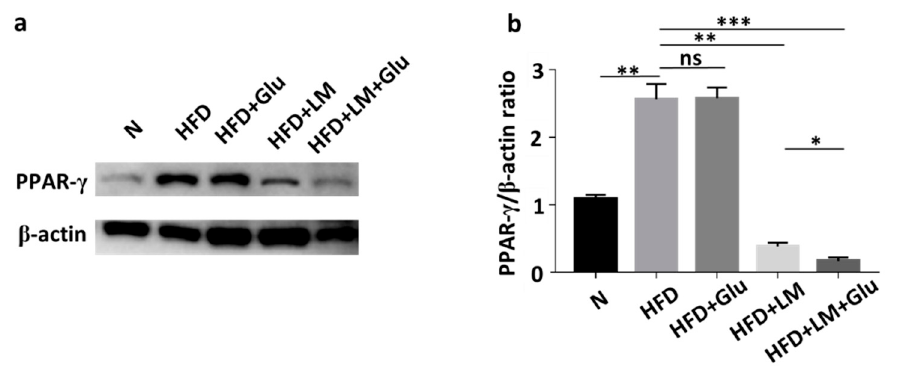
Figure 3. Attenuation of HFD-induced upregulation of PPAR- γ by L. mesenteroides EH-1. ( a ) The levels of PPAR- γ and β -actin in abdominal fat depots of mice fed with normal diet (N) or HFD along with glucose (Glu), L. mesenteroides EH-1 (LM) or L. mesenteroides EH-1 plus glucose every 3 days for 25 days were detected by western blot analysis. ( b ) The ratio intensities of PPAR- γ to β -actin were quantified. PPAR- γ expression (0.172 ± 0.050, n = 3) was reduced in HFD-fed mice with treatment of L. mesenteroides EH-1 and glucose (LM + Glu) compared to that (2.565 ± 0.224, n = 3) in HDF-fed mice without treatment or that (2.579 ± 0.158, n = 3) in HFD-fed mice with glucose. The mean ± SD for three separate experiments was calculated. * p < 0.05; ** p < 0.01; *** p < 0.001. ns = nonsignificant.